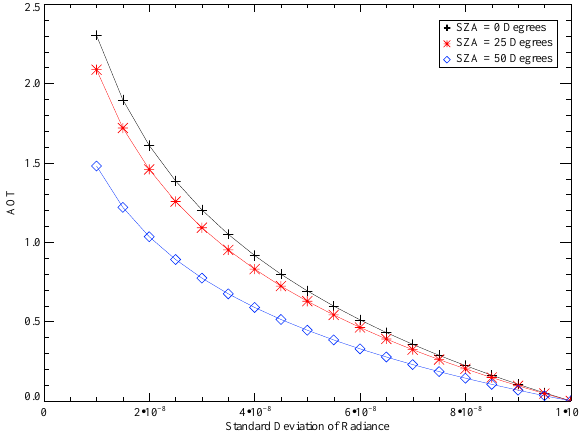
Figure 1. AOT computed by using Eq. (6) with varying standard deviations of radiance ( (cid:49)I sat , x axis) and satellite zenith angles, simulating retrievals made using the variation method. (cid:49)I a is held constant at 10 − 7 Wcm − 2 sr − 1 .